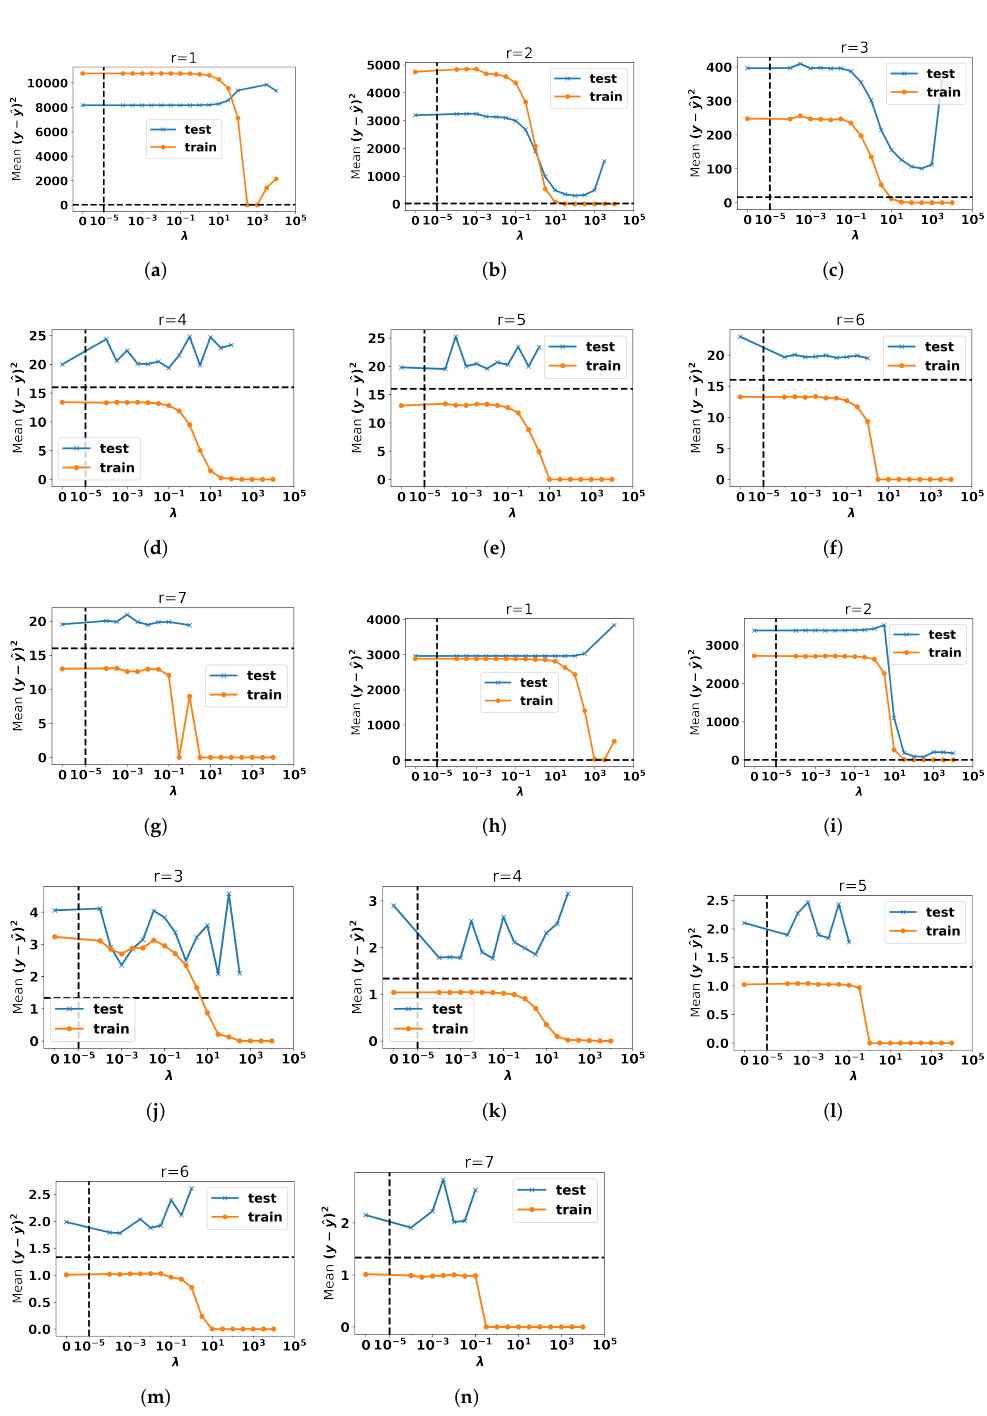
Figure 2. Regression errors with varying regression weight λ with different numbers of topics r for Gaussian noise ( a – g ) and uniform noise ( h – n ). The λ values used are the set { 0 } ∪ { 10 i /2 | i ∈ Z ∩ [ − 8,8 ] } . For each λ and r , fifty trials were run and the regression errors corresponding to the best overall objective function F ( λ ) were recorded. Points with λ > 0 for which the regression error exceeds 1.5 times the regression error at λ = 0 are not displayed. The dashed horizontal line is the estimated minimal mean regression error. The dashed vertical line is the transition point between a linear and logarithmic x